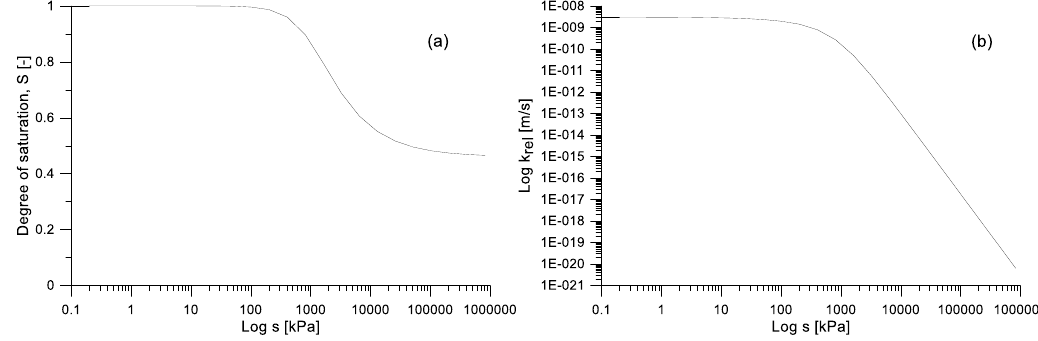
Figure 7. Soil water retention curve ( a ) and hydraulic conductivity function ( b ) used in the modelling (Table 1).